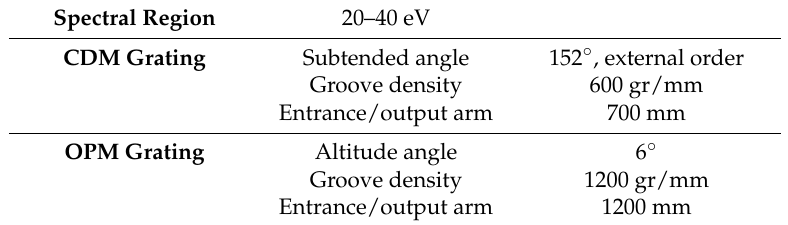
Table 1. Parameters of a monochromator with a target energy bandwidth of 50 meV at 30 eV.